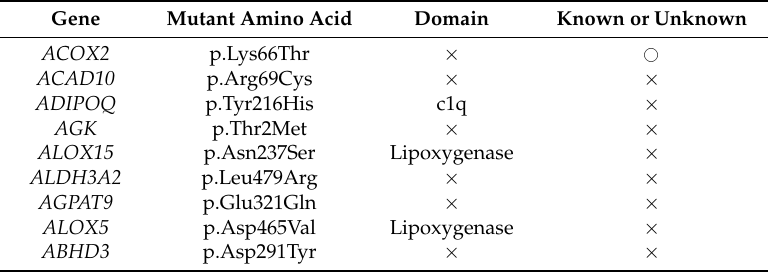
Table 4. Lipid-related